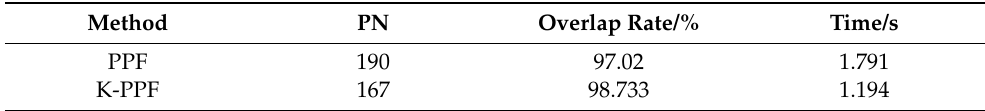
Table 3. Compared with original PPF. PN is the average number of scenes matching point pair